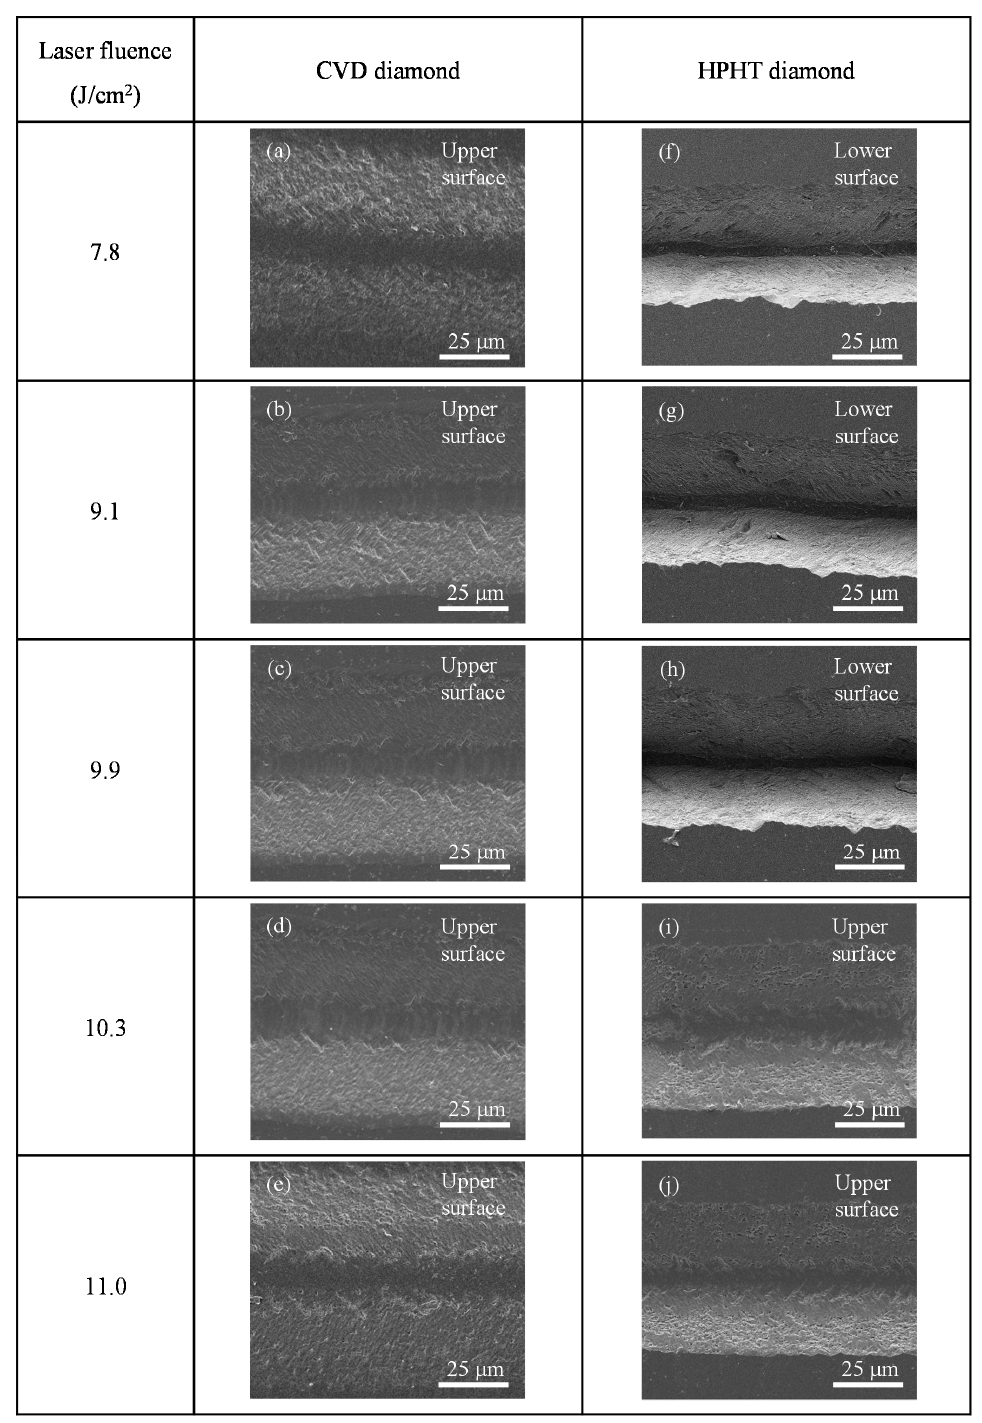
Figure 2. SEM images of the grooves obtained by irradiating with varying laser fluences on the CVD sample ( a ) 7.8 J/cm 2 ; ( b ) 9.1 J/cm 2 ; ( c ) 9.9 J/cm 2 ; ( d ) 10.3 J/cm 2 ; ( e ) 11.0 J/cm 2 ; and on the HPHT sample ( f ) 7.8 J/cm 2 ; ( g ) 9.1 J/cm 2 ; ( h ) 9.9 J/cm 2 ; ( i ) 10.3 J/cm 2 ; ( j ) 11.0 J/cm 2 .